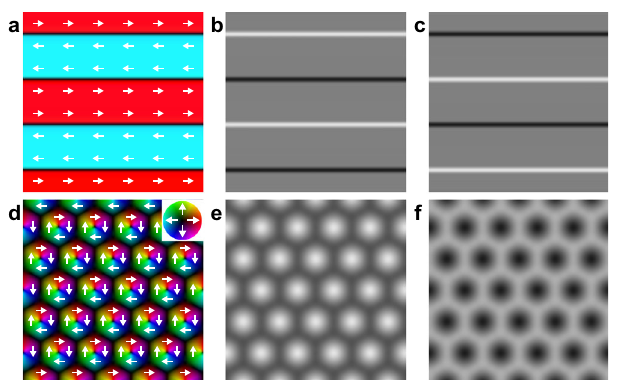
Fig. 1 Schematic of DWs and skyrmions, and the corresponding LTEM images. a Magnetic structure of DWs in ferromagnets. b , c Corresponding LTEM images of DWs for underfocused ( b ) and overfocused ( c ) conditions. d Magnetic structure of skyrmions. e , f Corresponding LTEM images of skyrmions for underfocused ( e ) and overfocused ( f )